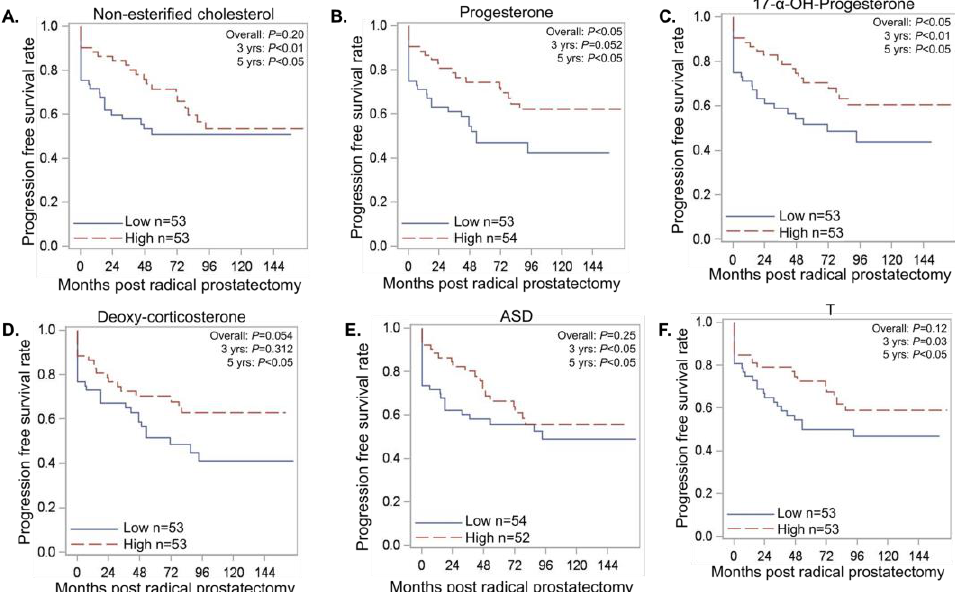
Figure 3. A subset of intermediate metabolites produced during androgen biosynthesis is reflective of a shorter time to disease progression. The metabolite levels were dichotomized into low (<=50th percentile) and high (>50th percentile). The time-to-event outcomes were then summarized by the categorized metabolite levels by using standard Kaplan–Meier methods, and associations were evaluated with standard log-rank tests. ( A – F ) Lower levels of intermediate androgen metabolites were found to be associated with a shorter time to disease progression; represented as progression-free survival on the Y-axis. ASD: androstenedione and T: